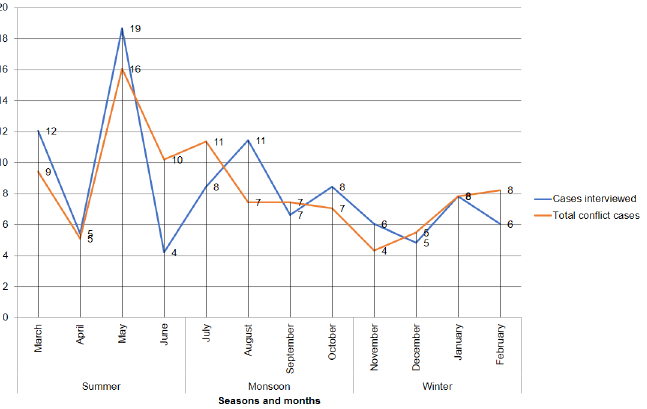
Fig 4. Seasonal and monthly variation of attack cases for victims interviewed ( n = 166) and caseson file ( n = 255) in percent.